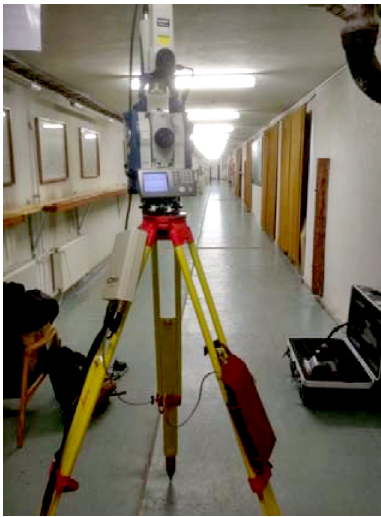
Figure 4. Determination of the device constant at the